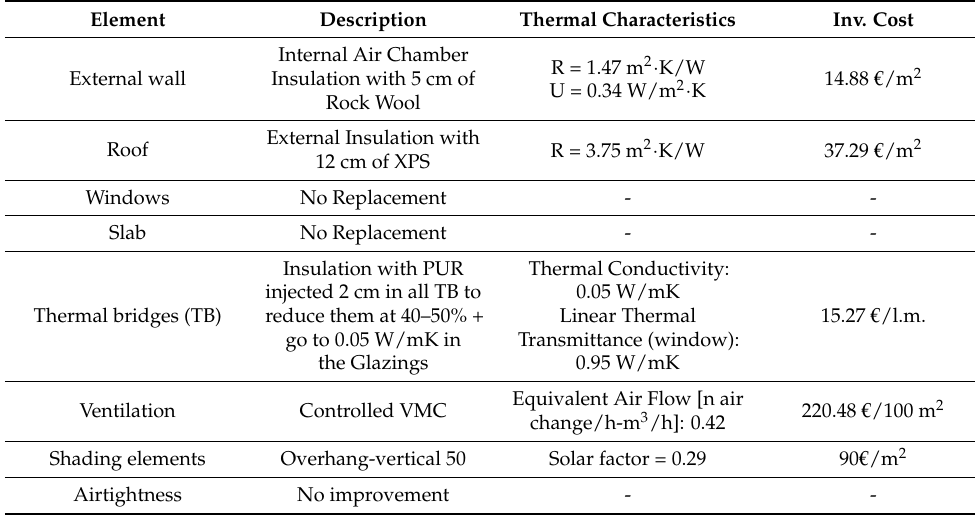
Table A2. POS4: Renovation measures of solution